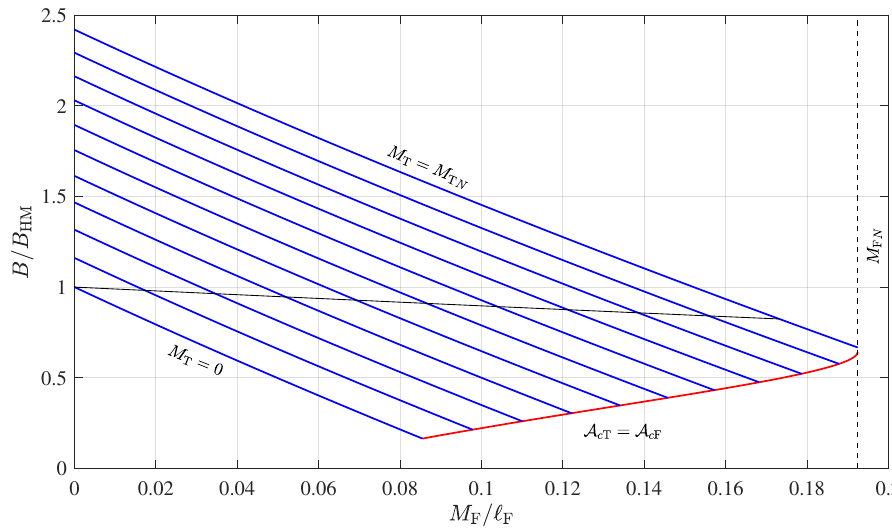
Figure 2 . Dependence of the tunnelling exponent B on the seed mass m F for l T =‘ F = 0 : 9. The blue lines correspond to di(cid:11)erent values of the remnant mass m T , starting at zero and increasing in steps of 0 : 1 m N T up to the Nariai limit. The area of the cosmological horizon is conserved along the red curve and decreases above it. Above the broken black line, the remnant black hole has a larger mass parameter than the